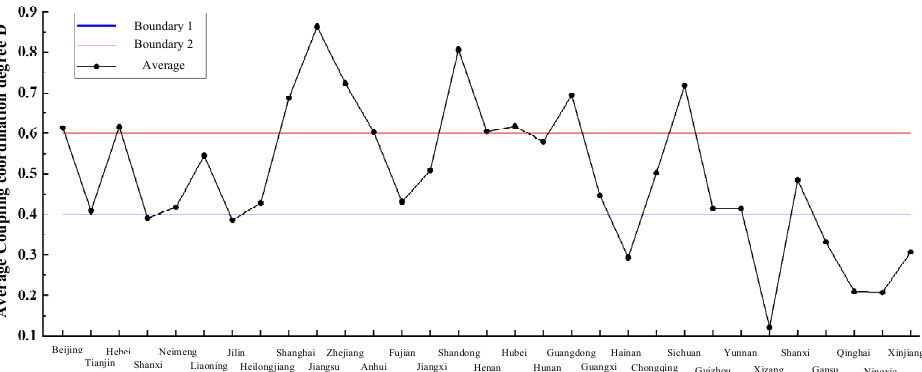
Figure 5. The mean coupling degree of supply and demand among various regions from 2010 to